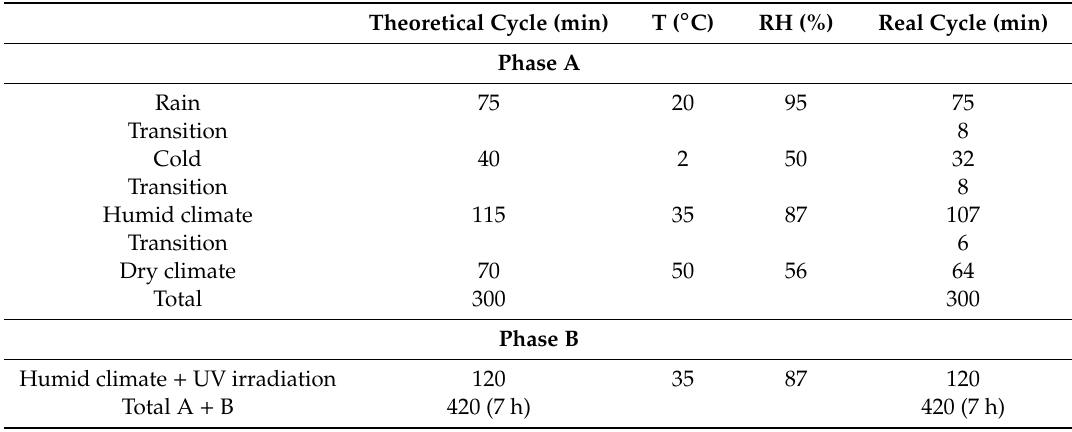
Table 2. Values of the parameters of accelerated